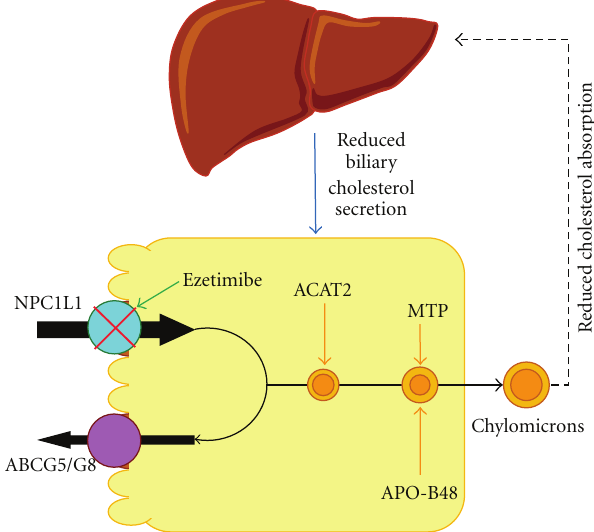
Figure 5: Pathways underlying the absorption of cholesterol from the intestinal lumen and its delivery to the liver. High dietary cholesterol delivery through the chylomicron pathway could provide an important source of excess cholesterol molecules for hepatic secretion into bile, thereby inducing cholesterol-supersaturated bile and enhancing cholesterol gallstone formation. Ezetimibe significantly suppresses cholesterol absorption from the small intestine via the Niemann-Pick C1-like 1 (NPC1L1) pathway, possibly by a transporter-facilitated mechanism. This e ff ect of ezetimibe could significantly diminish the cholesterol content of the liver, which in turn remarkably decreases bioavailability of cholesterol for hepatic secretion into bile. ABCG5/G8: ATP-binding cassette (transporters) G5 and G8; ACAT2: acyl- CoA:cholesterol acyltransferase isoform 2; APO-B48: apolipoprotein B48; MTTP: microsomal triglyceride transfer protein. See text for